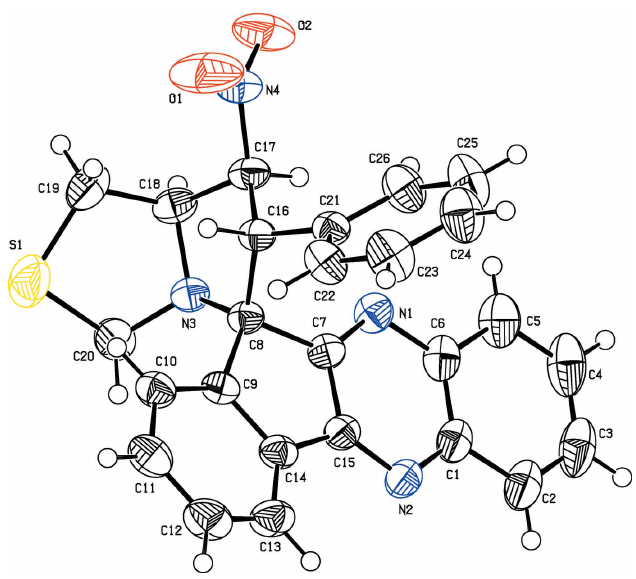
Figure 1 Perspective view of the title compound with the atom-numbering scheme and 50% probability displacement The title compound (Fig. 1) crystallizes with one molecule in the asymmetric unit. The thiazole ring exhibits an envelope conformation with the flap atom N3 deviating by 0.4598 (12) A˚ from the plane through the remaining ring atoms. The pyrroline ring also adopts an envelope confor- mation; the flap atom C17 deviates by 0.6678 (16) A˚ from the plane through the remaining ring atoms. The phenyl and indenoquinoxaline ring systems subtend an angle of 66.72 (1) (cid:2) . The molecular conformation is stabilized by intramolecular C—H (cid:3) (cid:3) (cid:3) N and C—H (cid:3) (cid:3) (cid:3) O interactions (Table 1), each of which forms an S (6) motif.